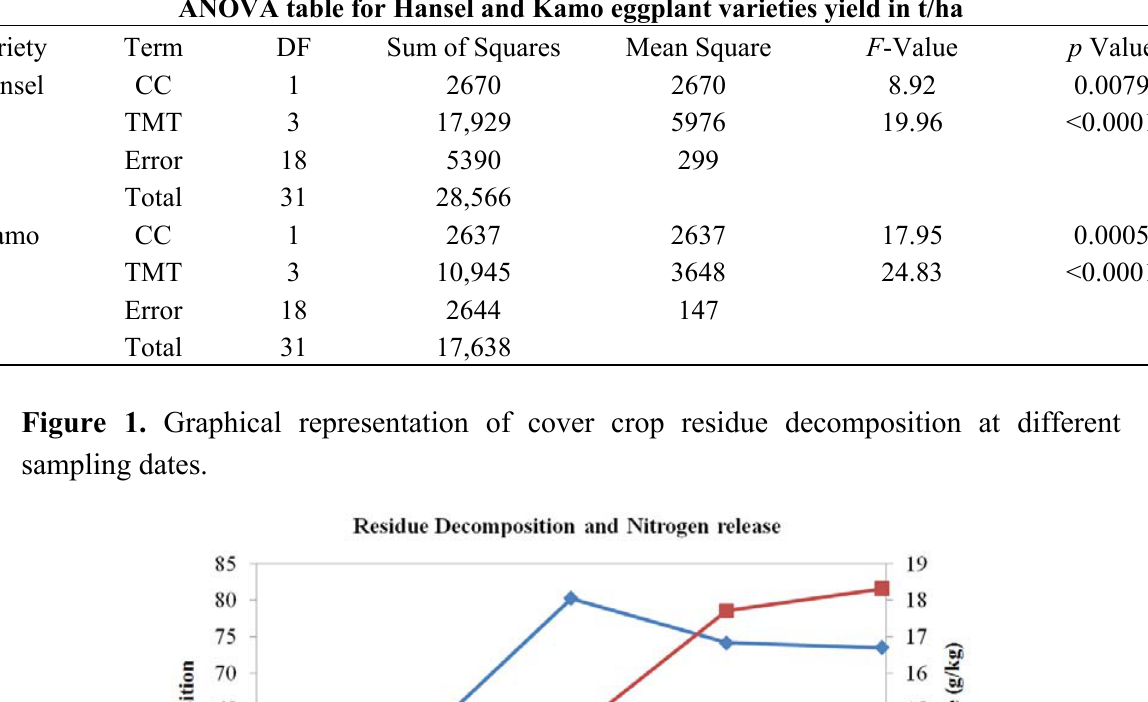
Table 2. ANOVA table showing the significant differences among treatments and varieties in the eggplant study. CC stands for cover crop, TMT is treatment. ANOVA table for Hansel and Kamo eggplant varieties yield in t/ha Variety